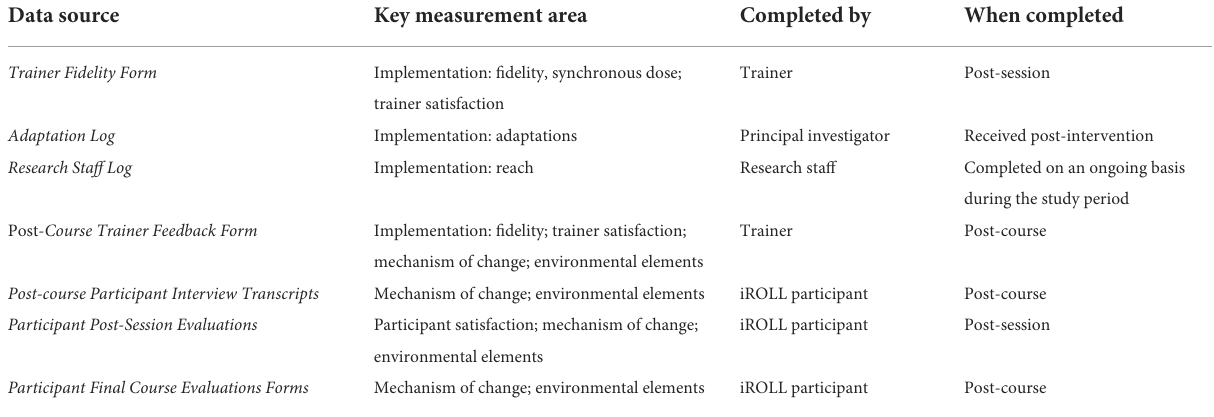
TABLE 2 iROLL-O process evaluation data collection